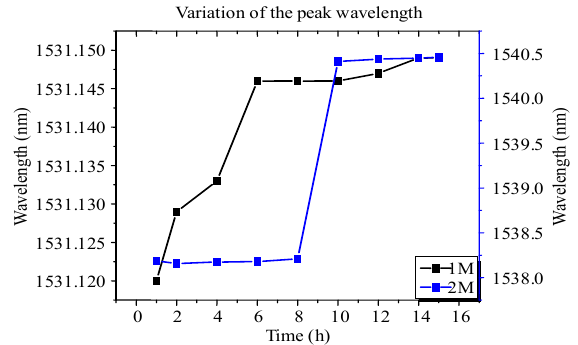
Fig. 5 Variation of the TFBG transmission spectrum.